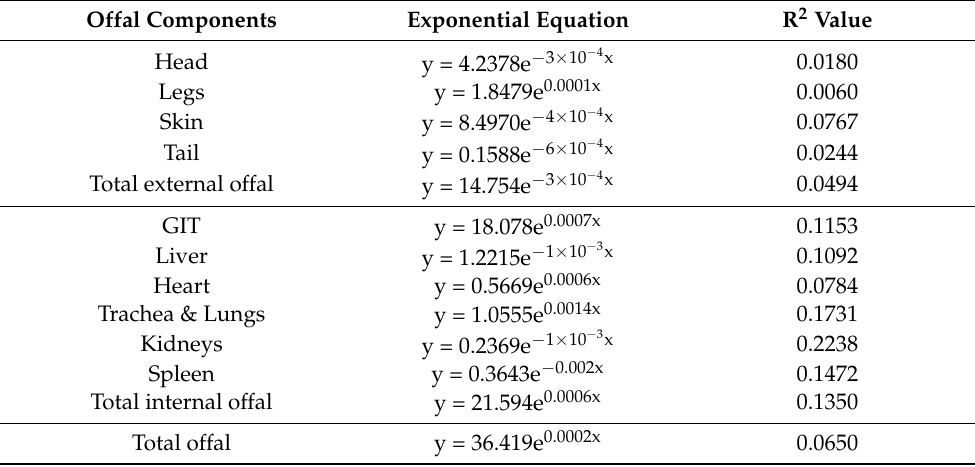
in the total offal can be attributed to the exponential relationship with age. Table 4. The coefficient of determination (R 2 value) and the exponential equation to indicate the relationship between the respective offal components and age of Plains zebra stallions (aged between 2 and 13 years) harvested during a summer season in the Western Cape Province of South Africa. Offal Components